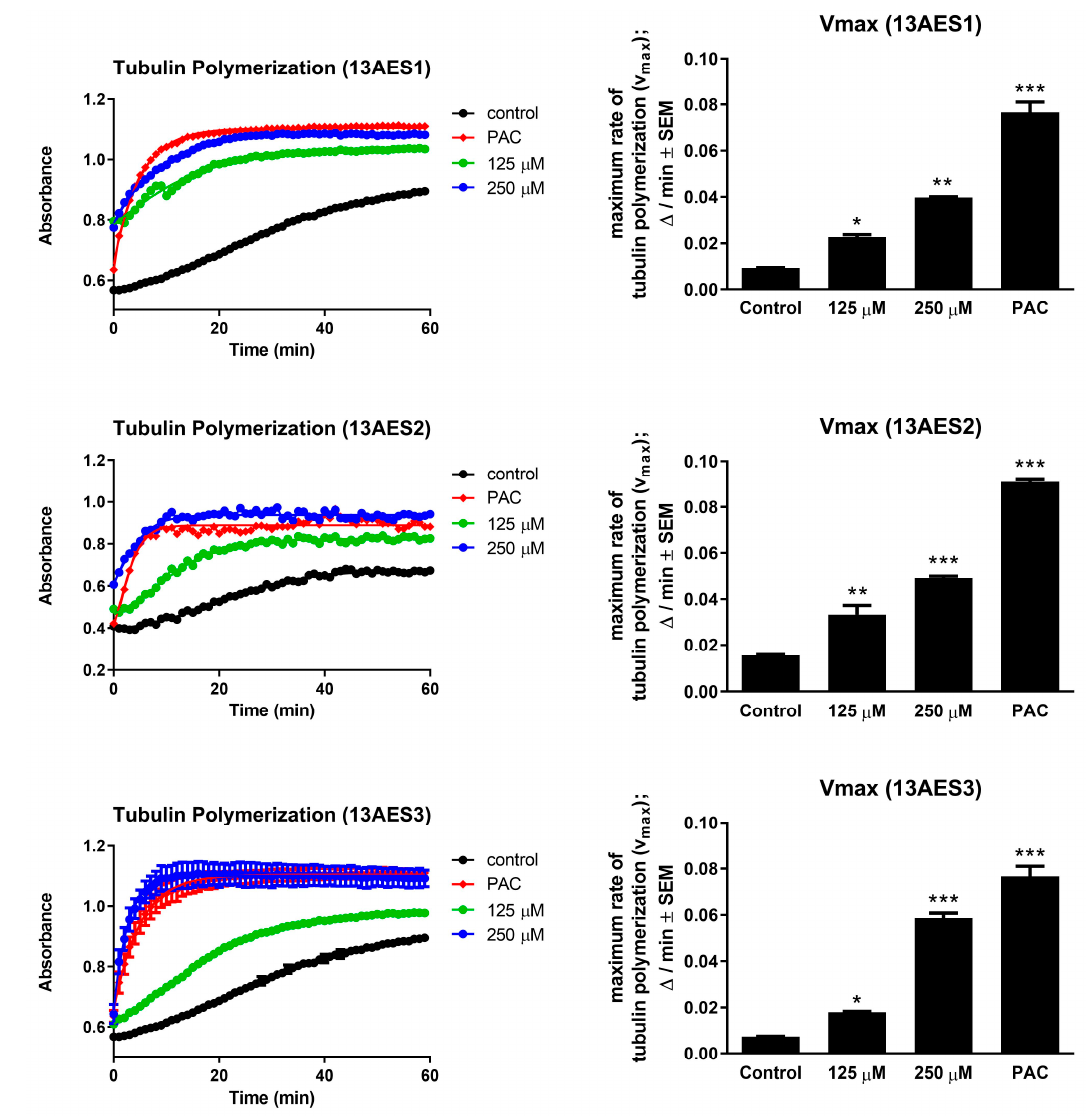
Figure 5. Tubulin polymerization assay. Left panels : trends of tubulin polymerization compared to the positive control (paclitaxel, PAC, 10 μ M) and to vehicle. Right panels : calculated maximum rates of tubulin polymerization (Vmax). *, **, and *** indicate significance at p < 0.05, p < 0.01, and p < 0.001, respectively.